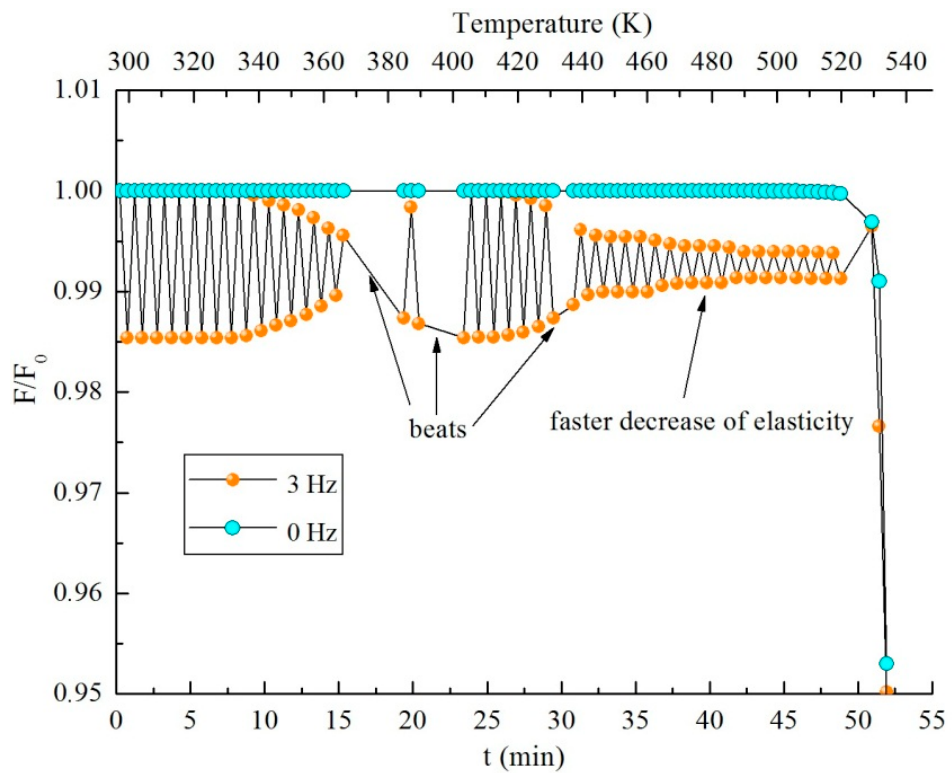
Figure 4. The calculated relations of reaction force F ( t )/ F 0 of the specimen: with the cyclic load—the orange circles and without it—the cyan circles.